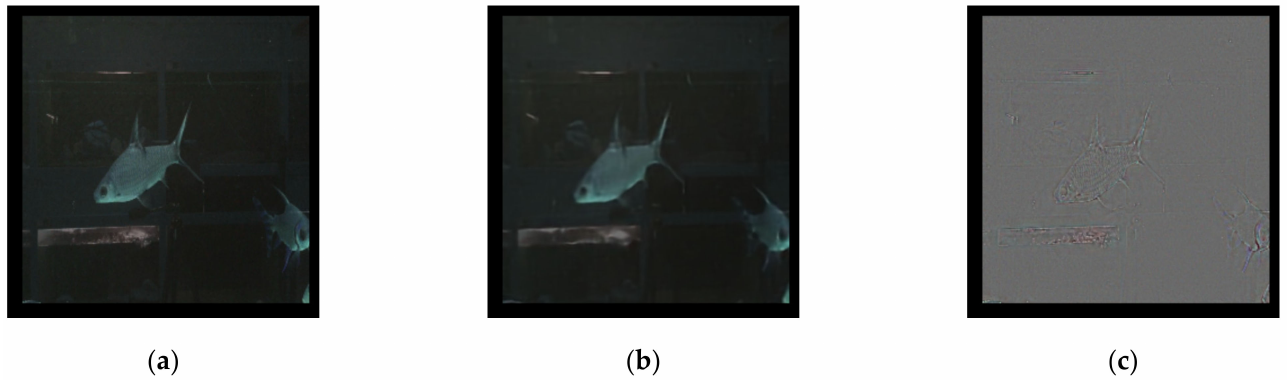
Figure 8. CNN cropped image autoencoder against full sample results: ( a ) source, ( b ) reconstructed, and ( c )